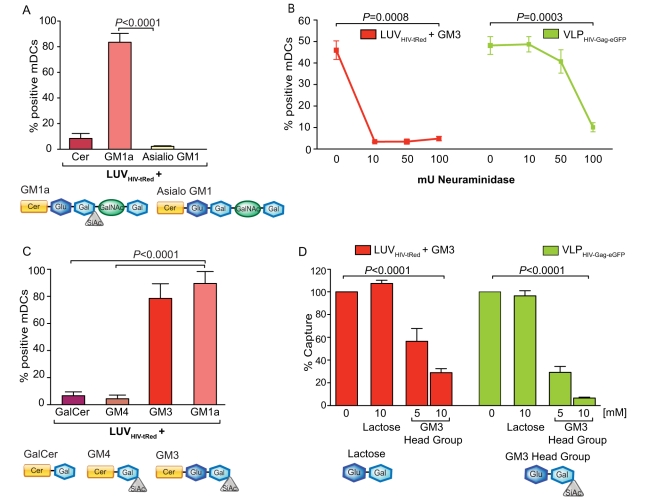
Identification of the molecular recognition domain present in gangliosides essential for mDC capture.(A) Comparative mDC capture of distinct LUVHIV-tRed containing Cer, GM1a, or GM1 lacking sialic acid (Asialo GM1). A total of 2×105 DCs were pulsed for 4 h at 37°C with 100 µM of LUVs, washed with PBS, and assessed by FACS to obtain the percentage of tRed-positive cells. Data show mean values and SEM from three independent experiments, including cells from nine donors. mDCs capture significantly higher amounts of GM1a-containing LUVHIV-tRed than Asialo GM1-containing LUVHIV-tRed (p<0.0001, paired t test). Schematic of the gangliosides present in the LUVs of these experiments is shown underneath. (B) Comparative mDC capture of GM3-containing LUVHIV-tRed and VLPHIV-Gag-eGFP treated or not with neuraminidase to remove sialic acid. A total of 2×105 DCs were pulsed for 2 h at 37°C with 25 µM of LUVs and 75 ng of VLPHIV-Gag-eGFP Gag treated or not with C. perfringens neuraminidase for 12 h, washed with PBS, and assessed by FACS to obtain the percentage of tRed- and eGFP-positive cells. Data show mean values and SEM from two independent experiments including cells from five donors. mDCs capture significantly higher amounts of untreated particles than neuraminidase-treated particles (p-values on the graph, paired t test). (C) Comparative mDC capture of distinct LUVHIV-tRed containing GalCer, GM4, GM3, or GM1a. A total of 2×105 DCs were pulsed for 4 h at 37°C with 100 µM of LUVs, washed, and assessed by FACS to obtain the percentage of tRed-positive cells. Data show mean values and SEM from three independent experiments including cells from nine donors. mDCs capture significantly higher amounts of GM1a-containing LUVHIV-tRed than GalCer or GM4-containing LUVHIV-tRed (p<0.0001, paired t test). Schematic of the molecules present in the LUVs for these experiments is shown underneath. (D) Graph representing the relative capture of GM3-containing LUVHIV-tRed and VLPHIV-Gag-eGFP by mDCs that had been pre-incubated with 10 mM of soluble lactose or with 5–10 mM of GM3 carbohydrate polar head group, normalized to the level of LUV/VLP capture by mock-treated mDCs (set at 100%). mDCs captured fewer particles upon treatment with GM3 polar head group (p-values on the graph, paired t test). Data show mean values and SEM from three independent experiments including cells from at least nine donors.